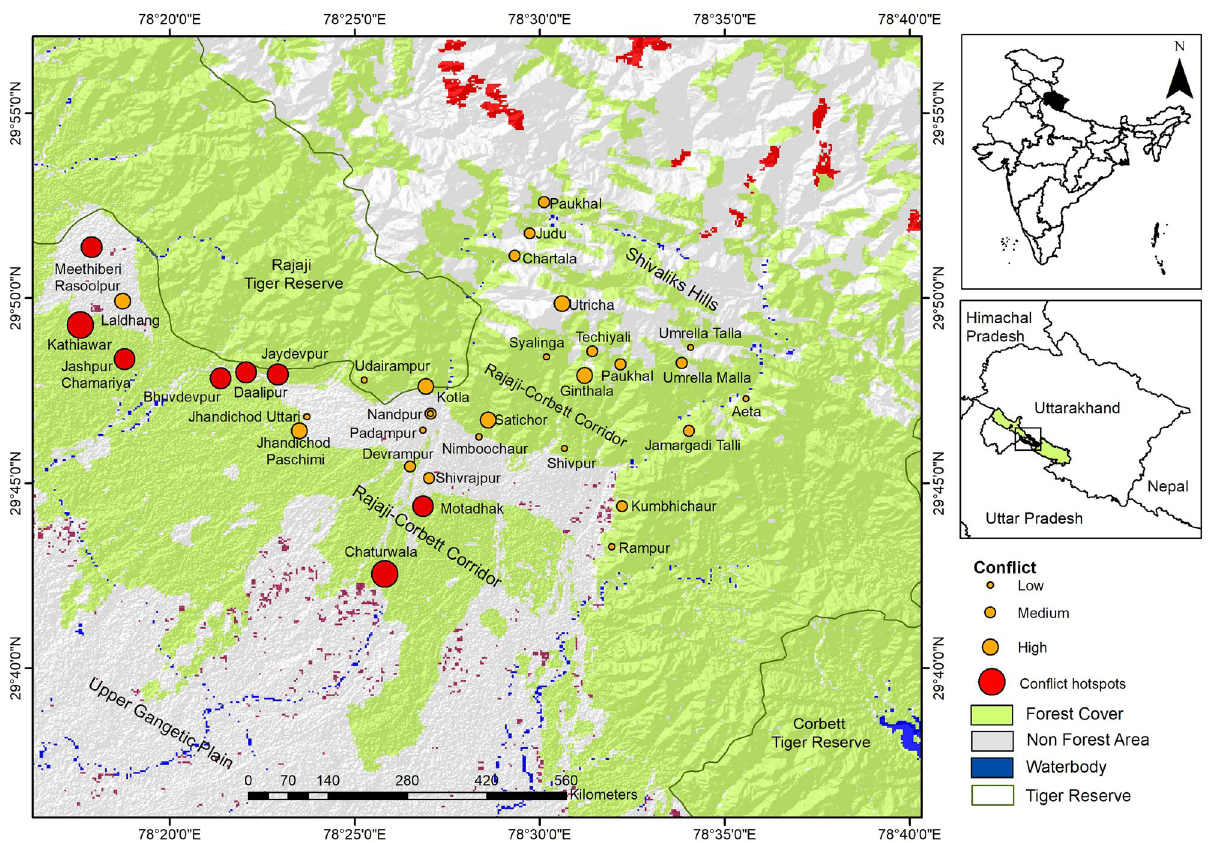
Figure 3. Villages identified as conflict hotspots based on average cost incurred (US $ hh −1 year −1 ) due to livestock depredation and crop raiding around the forest corridor linking the Rajaji and Corbett Tiger Reserves, Uttarakhand, India. Land cover used was downloaded from Diva-Gis (http://www.diva-gis.org/gdata ). The map was created using ArcGIS v.10.3.1 software developed by ESRI (https